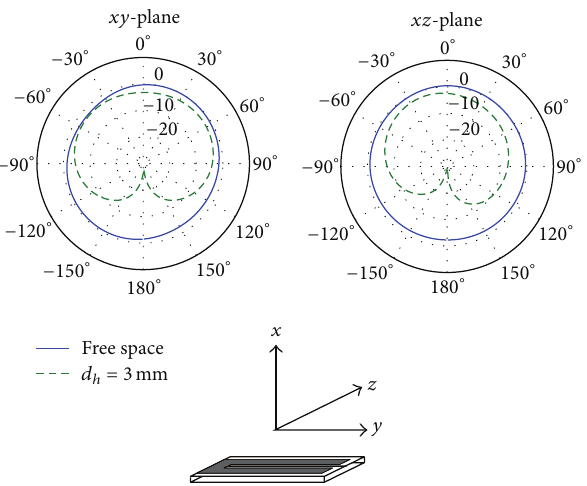
Figure 9: Simulated gain of the final design (with silver fabric) at a frequency of 923